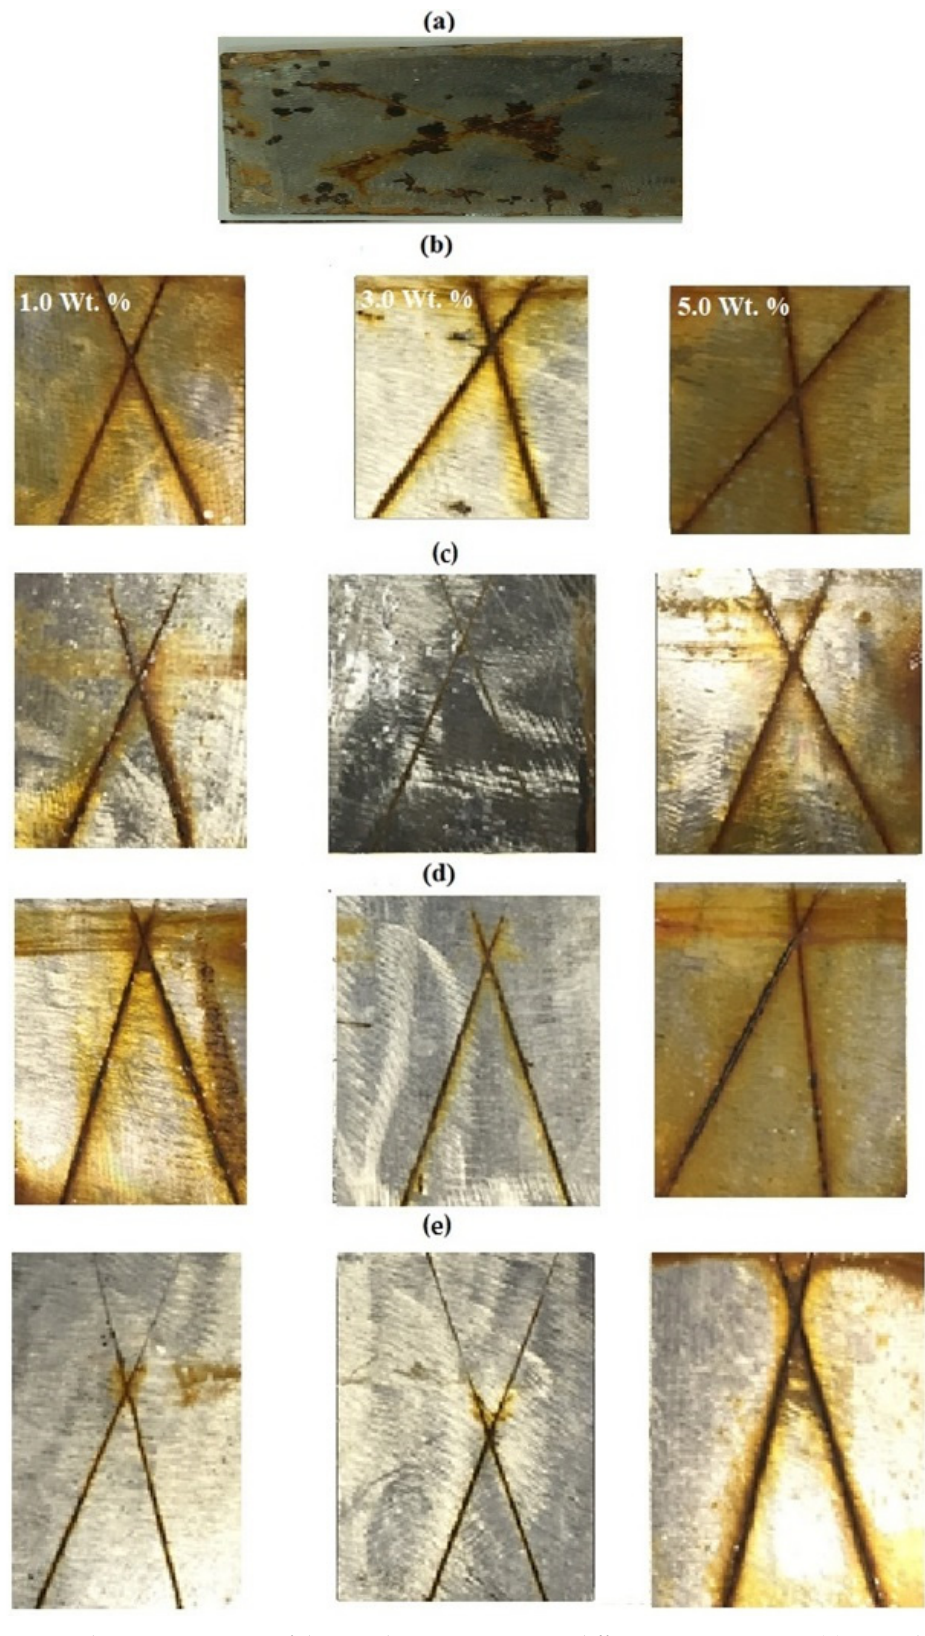
Figure 8. Salt-spray resistance of the cured epoxy coatings at different exposure times ( a ) epoxy blank after 500 h, ( b ) epoxy modified with SG after 650 h, ( c ) epoxy modified with AS after 750 h, ( d ) epoxy modified with STHa after 1750 h and ( e ) epoxy modified with STHa after 2000 h at 35 °C.